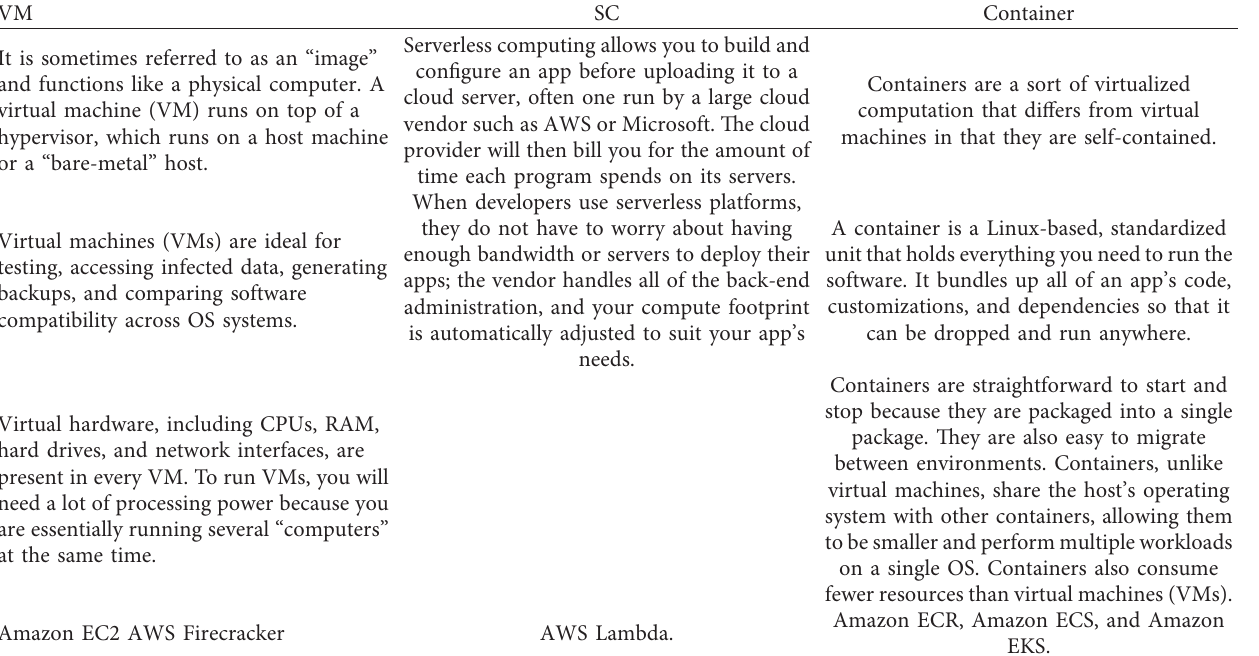
Table 2: Serverless computing, virtual machines, and container compared in a cloud computing environment [15]. VM SC